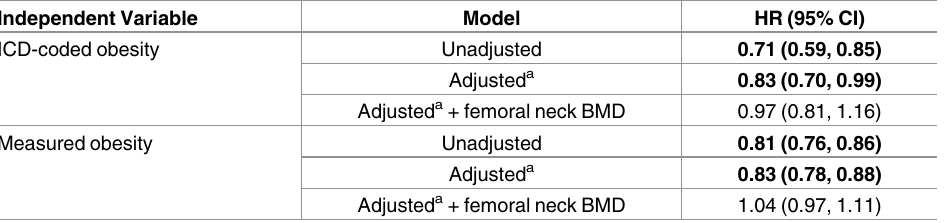
a Adjusted for age, sex, prior fractures, prolonged glucocorticoid use, COPD diagnosis, alcohol/substance abuse diagnosis, rheumatoid arthritis diagnosis, and income quintiles. NA: Not applicable. Bold-faced values indicate statistical significance at α = 0.05.